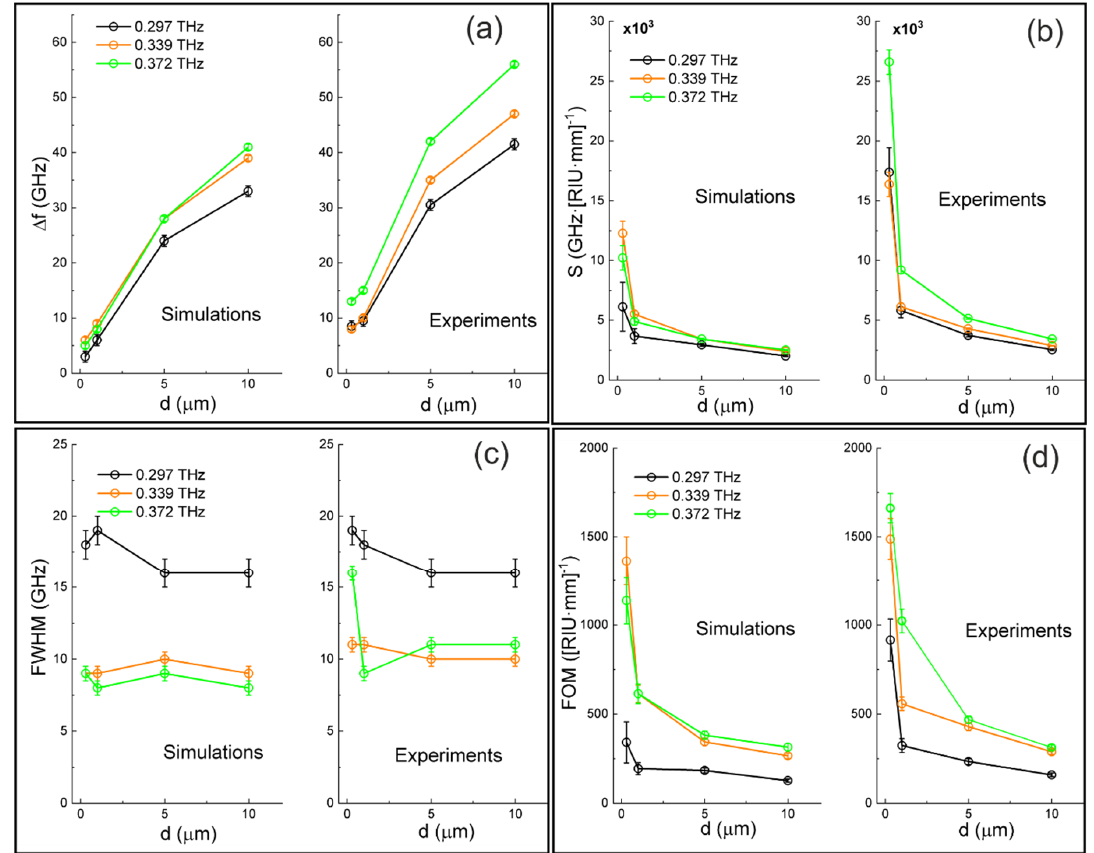
Figure 5. Sensor parameters for the distantly spaced ( p = 768 µm) spiral disks with 90° C-resonator, evaluated from the transmittance spectra in Figure 4: ( a ) the frequency shifts Δ f of resonances at 0.297, 0.339 and 0.372 THz vs. photoresist thickness d (left—simulations, right—experiments); ( b ) the sensitivity of S vs. d; ( c ) the full width at the half minimum ( FWHM ) vs. d ; (d) figure of merit ( FOM) vs. d .